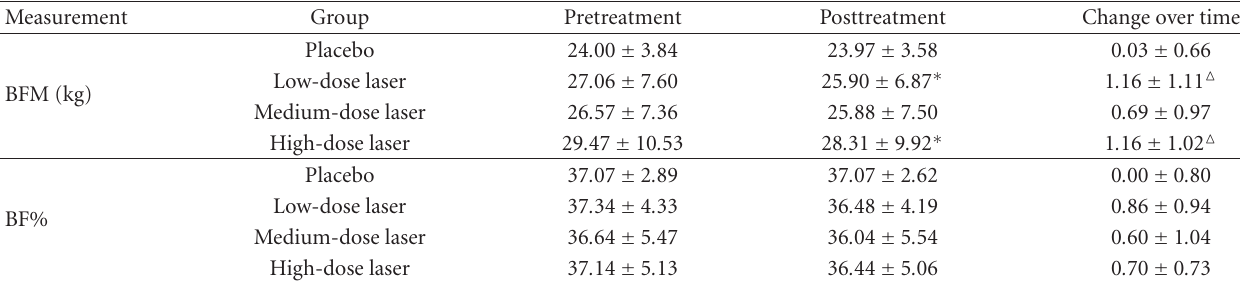
Table 3: Waist girth, hip girth, and waist-to-hip ratio data in the placebo group and the three laser groups before and after treatment. Measurement Group Pretreatment Posttreatment Change over time Placebo 87 . 71 ± 6 . 10 88 . 21 ± 6 . 53 − 0 . 50 ± 1 . 22 Low-dose laser 90 . 77 ± 12 . 23 88 . 43 ± 11 . 07 ∗ 2 . 34 ± 1.96 (cid:2)(cid:2) WG (cm) Medium-dose laser 90 . 03 ± 7 . 57 High-dose laser Placebo 101 . 71 ± 5 . 64 Low-dose laser 104 . 79 ± 6 . 47 HG (cm) Medium-dose laser 105 . 64 ± 9 . 16 High-dose laser 105 . 93 ± 9 . 68 105 . 29 ± 9 . 55 Placebo 0 . 86 ± 0 . 05 Low-dose laser WHR